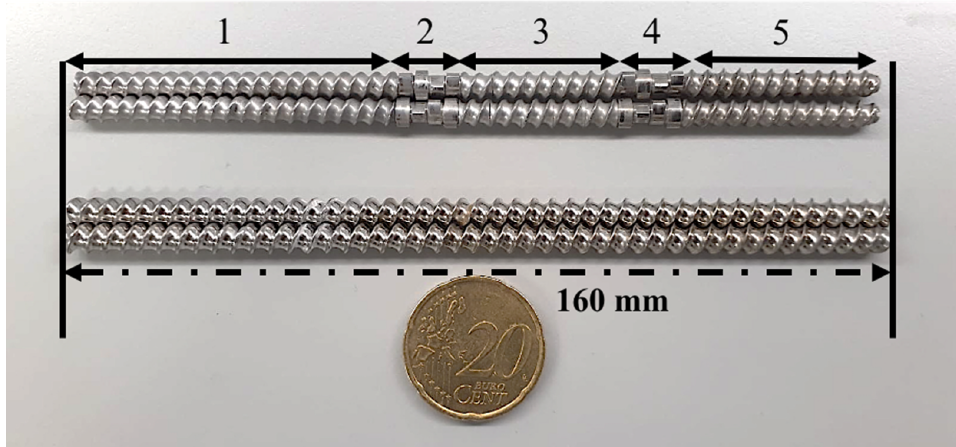
Figure 2. Screw configuration of ( top ) integrated conveying and kneading elements: ( 1 ) 1st conveying zone, ( 2 ) 1st kneading zone, ( 3 ) 2nd conveying zone, ( 4 ) 2nd kneading zone, ( 5 ) 3rd conveying zone, ( bottom ) screw with only conveying elements.